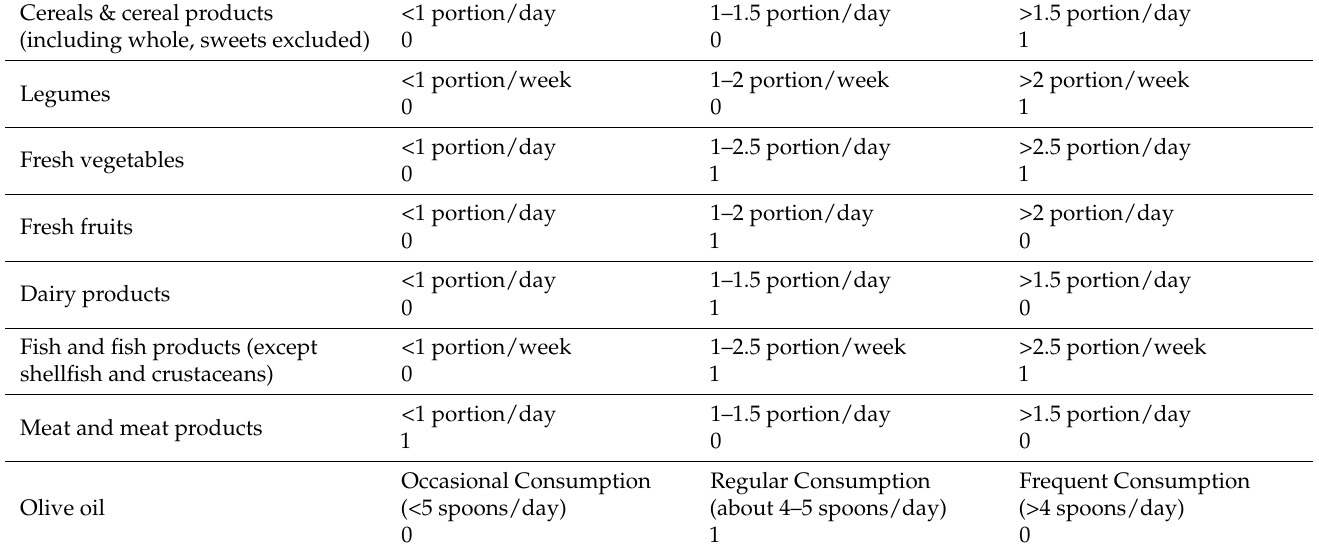
Table 3. Sustainable diet